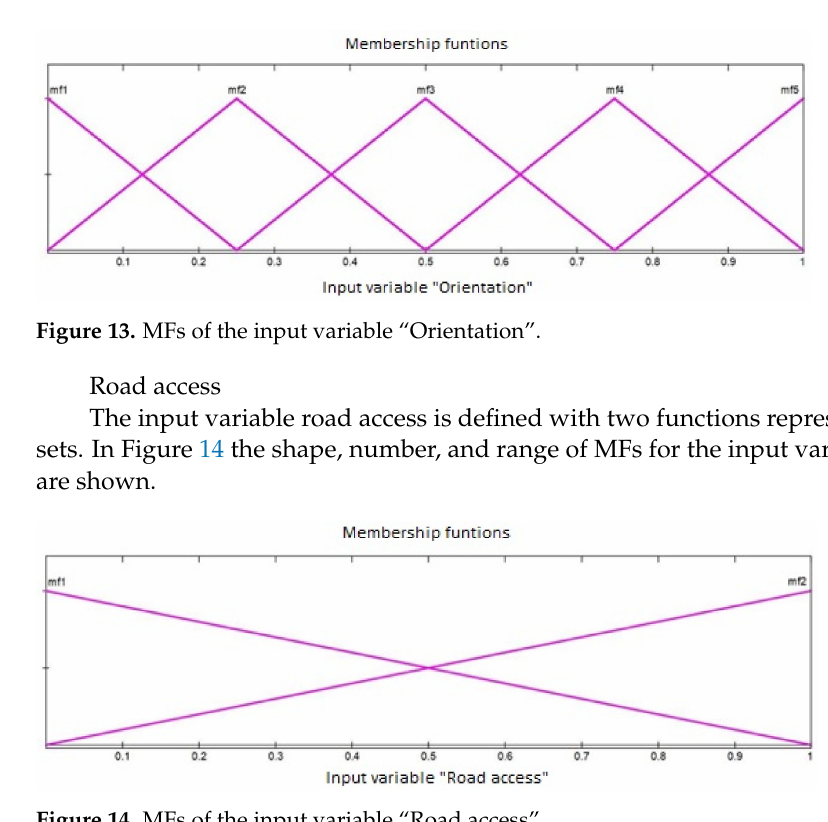
Figure 14. MFs of the input variable “Road access”. Distance from main roads